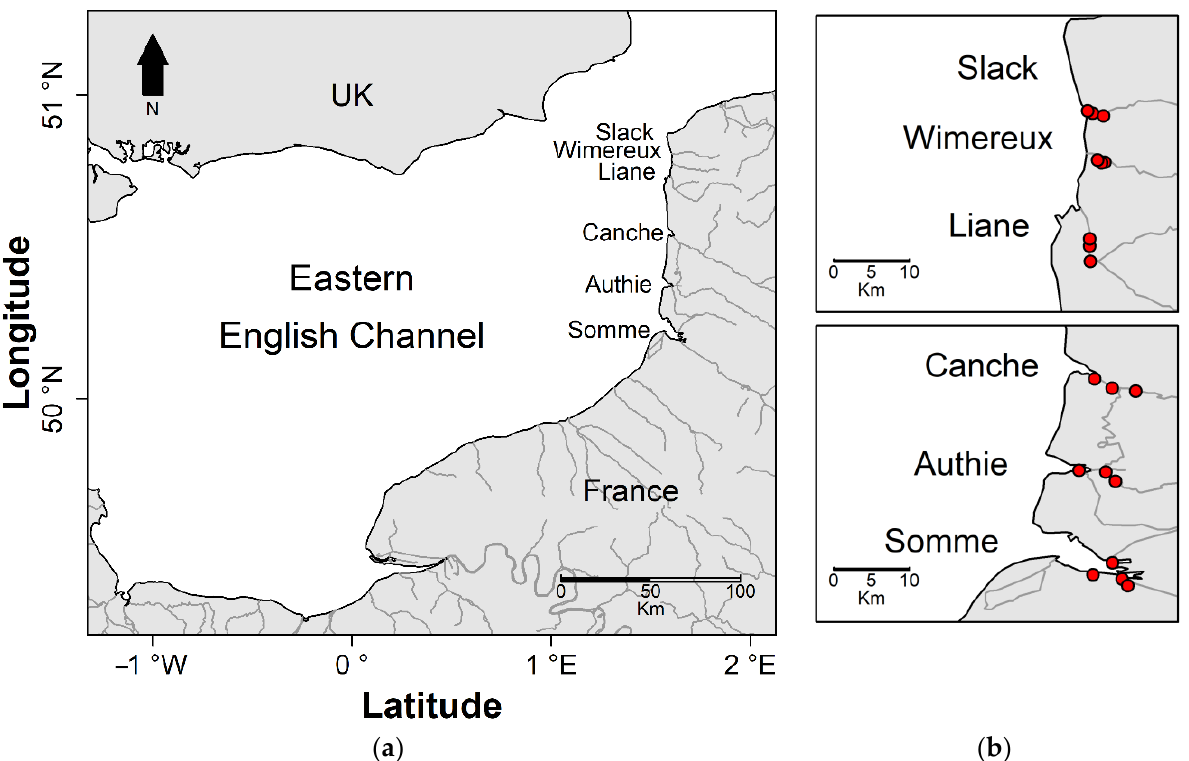
Figure 1. Location of ( a ) the six sampling estuaries along the French coast of the Eastern English Channel and ( b ) location of the three or four sampling stations per estuary (red dot).